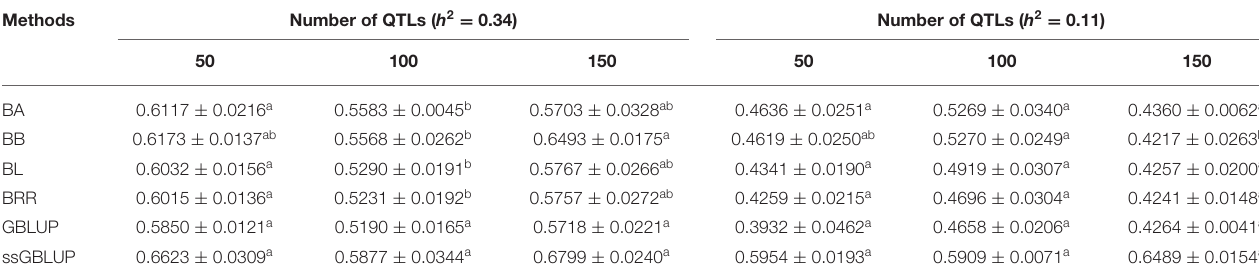
TABLE 6 | Accuracy of GEBV in three QTLs with heritability of fiber diameter and live body weight under different methods. Methods